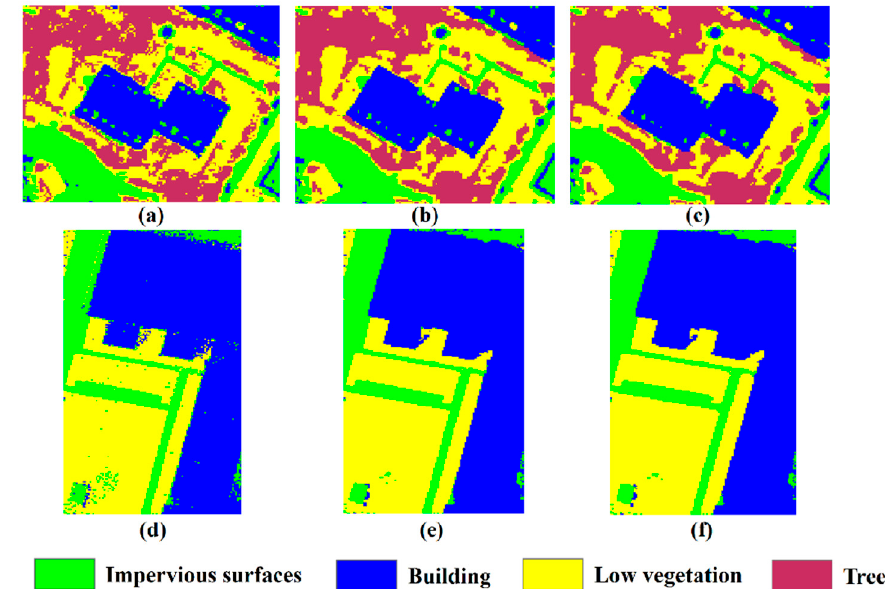
Figure 8. Original classification maps (OCMs), FCM_SFs, and FCM_ DR_SFs of Vaihingen and Potsdam images: ( a ) OCM of Vaihingen; ( b ) FCM_SF of Vaihingen; ( c ) FCM_ DR_SF of Vaihingen; ( d ) OCM of Potsdam; ( e ) FCM_SF of Potsdam; and ( f ) FCM_ DR_SF of Potsdam.